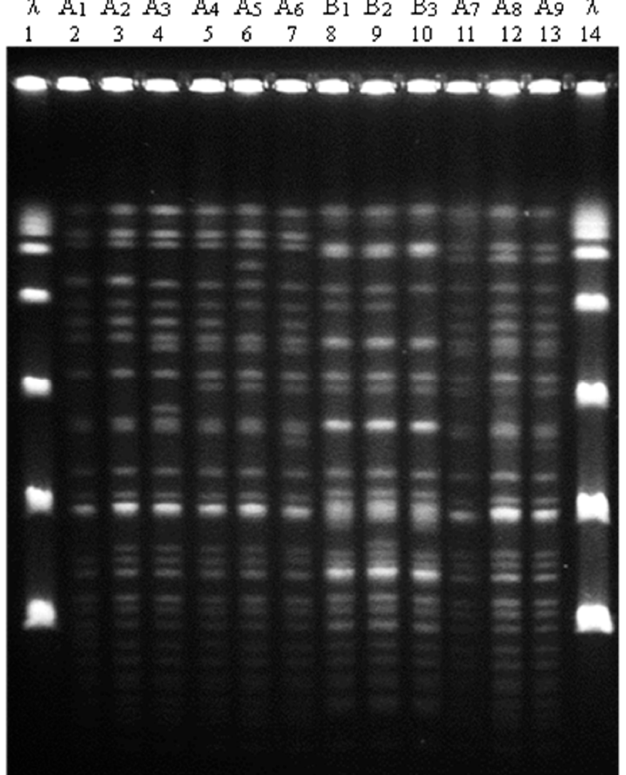
Figure 1. Apa I PFGE patterns of A. baumannii strains isolated from SARS ‑ CoV ‑ 2 patients admitted to the intensive care unit of the Umberto I teaching hospital of Rome between 1 March 2020 and 28 February 2021. Representative isolates of A. baumannii strains are shown in lanes 2–7, 11–13 (PFGE pattern A), and 8–10 (pattern B). Lines 1 and 14 contain molecular size patterns (lambda ladder 48.5 kb). The most prevalent PFGE subtypes occurred in a well ‑ defined temporal period: subtype A 4 (26.5%) was predominant in April 2020 and then disappeared before showing and January 2021 and again in March 2021. Subtype B 1 (45.1%), however, appeared in